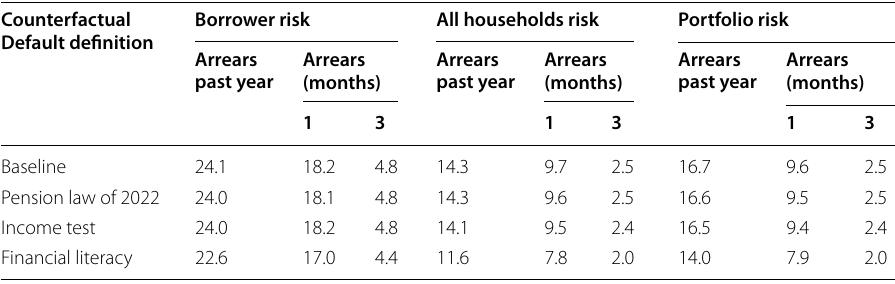
All households’ risk takes into account that households with no debts have zero risk. Portfolio risk takes into account the size of the loans held by each